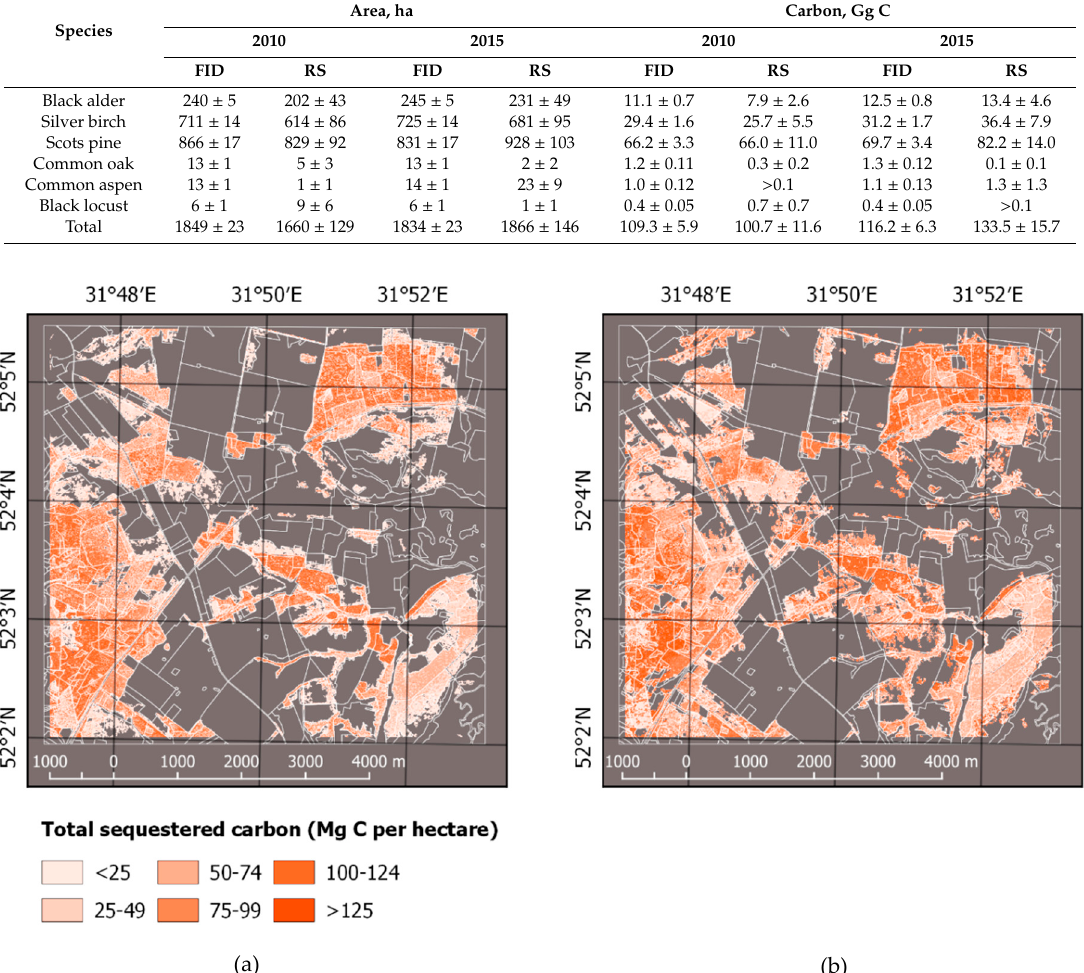
Table 9. Forest gain and loss, 2015.